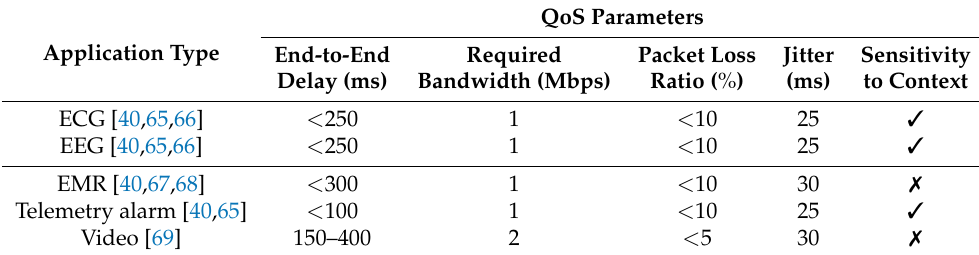
Table 4. Quality of service requirements for e-Health